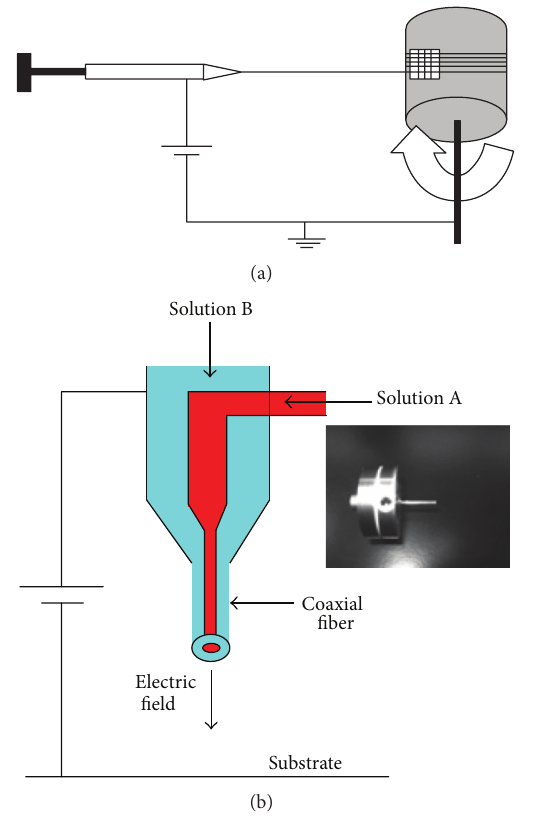
Figure 1: (a) Electrospinning with a grounded rotating drum. (b) Coaxial electrospinning.